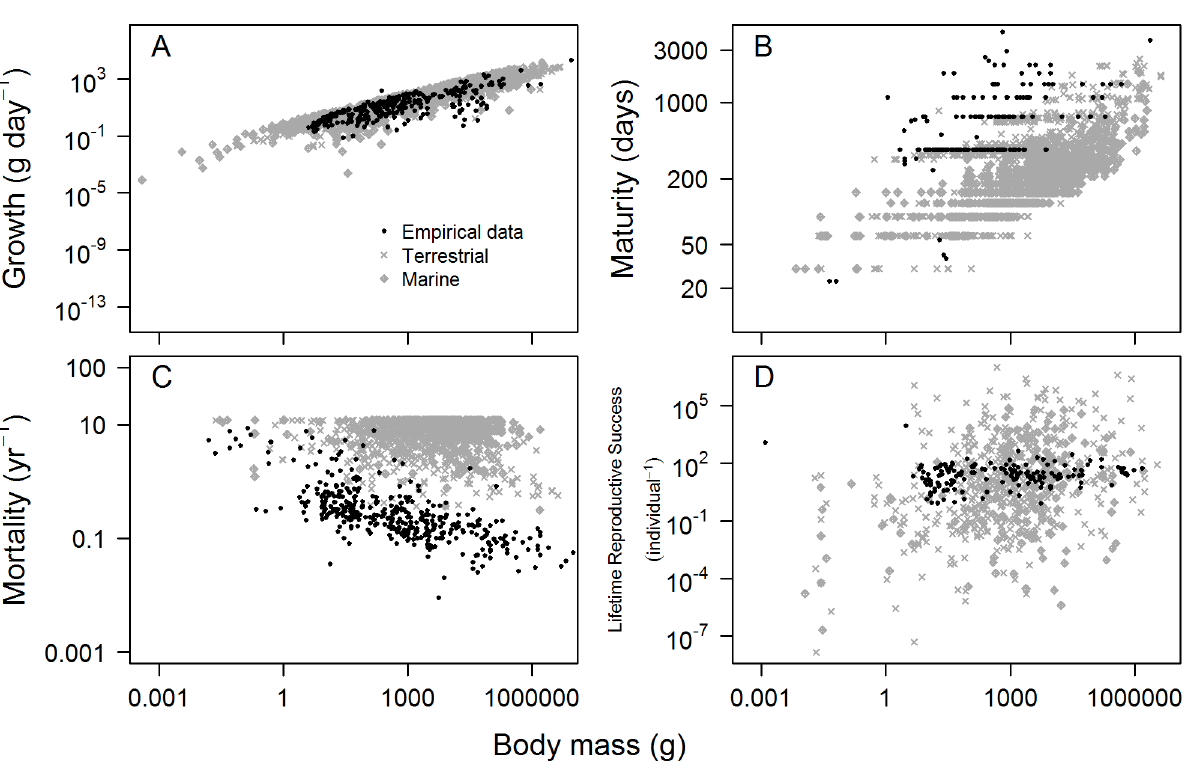
Figure 3. Comparison of emergent life history metrics with empirical data. Empirical (black) and emergent model (grey) relationships between body mass and (A) growth rate, (B) maturity, (C) individual mortality rates, and (D) lifetime reproductive success. These life history metrics are not part of the model definition. Rather, they emerge from underlying ecological processes such as metabolism and feeding (see main text). Life history metrics were sampled from 100-y model runs for the four focal grid cells (Table 4). Individual mortality rates are estimated as the inverse of lifespan, and because the minimum simulated lifespan is one model time step (1 mo), estimated individual mortality rates were bounded at 12.